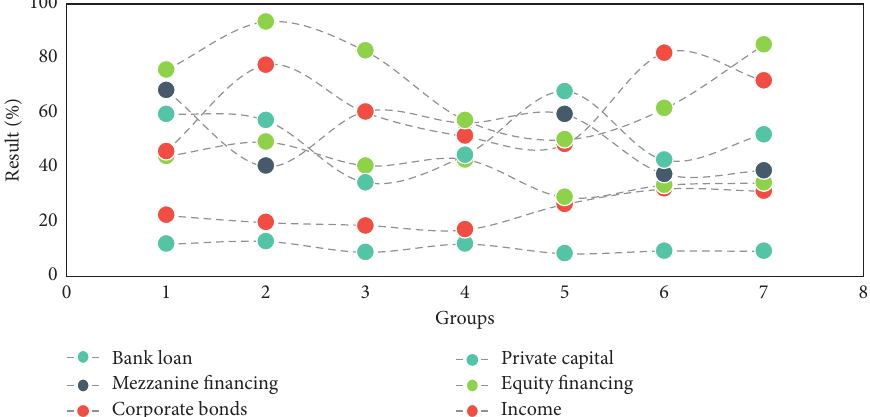
Figure 10: Financing progress of smart city infrastructure construction projects.